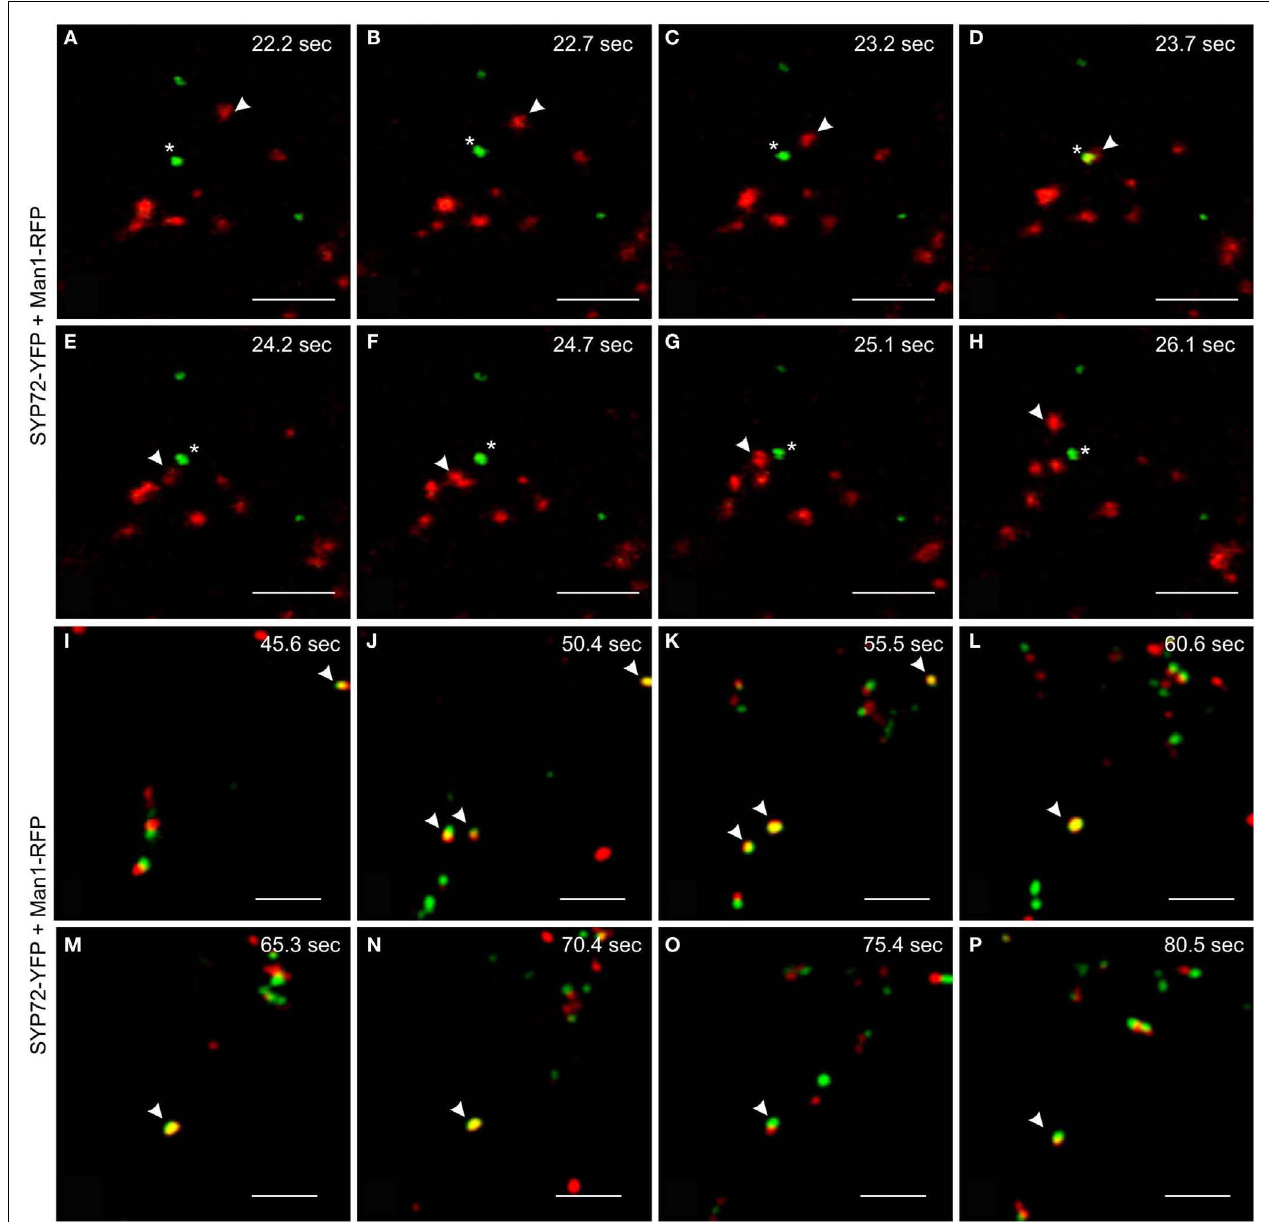
(arrowhead) is seen moving toward and over a SYP72-YFP puncta (star). (I–P) SYP72-YFP (in green) and Man1-RFP (in red) are shown in these eight frames (5s interval; movie available as Movie S3 in Supplementary Material). Several examples of temporary colocalization between SYP72-YFP and Man1-RFP signals are to be seen (arrowhead). Magnification bars = 5 µ m (A–P)